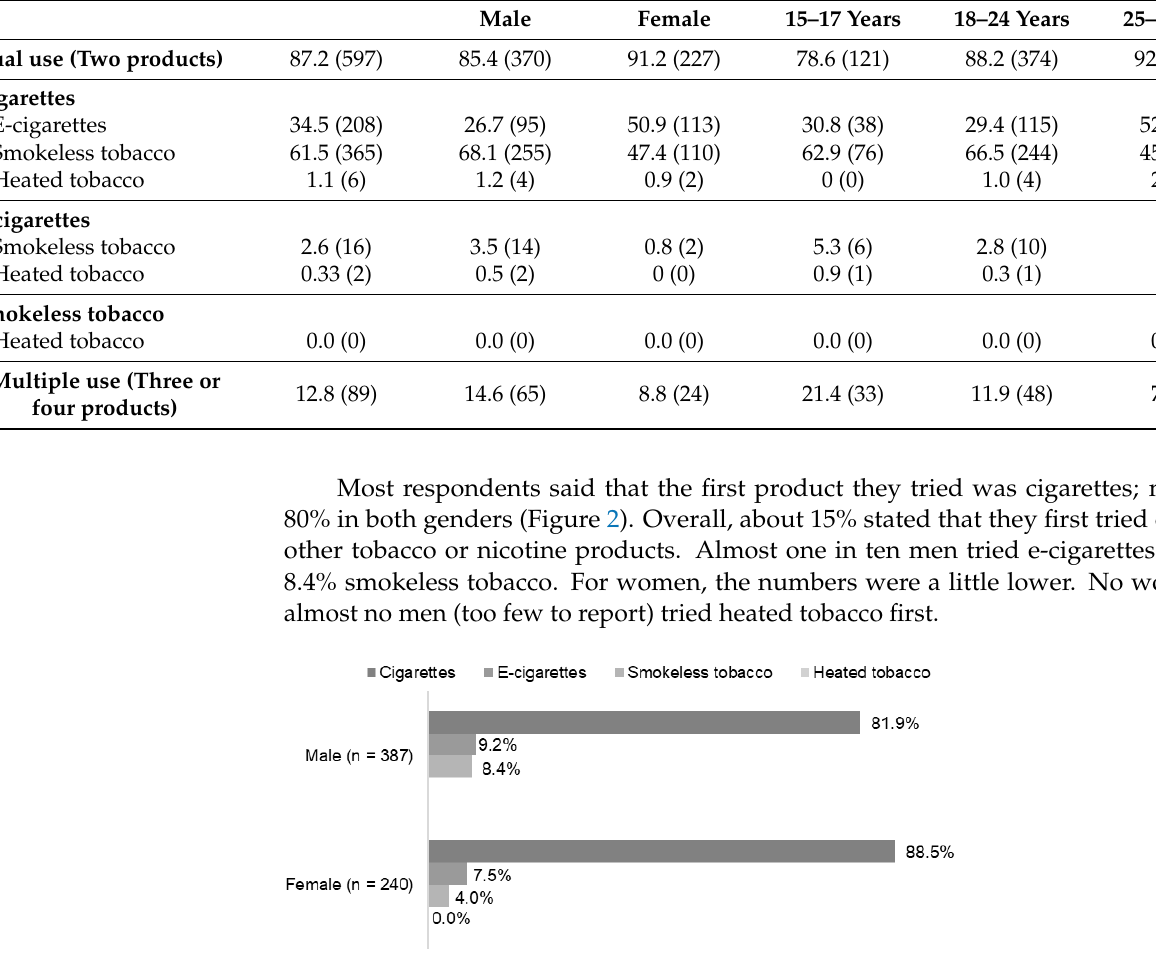
Table 4. Dual and multiple use of tobacco or nicotine-containing products.